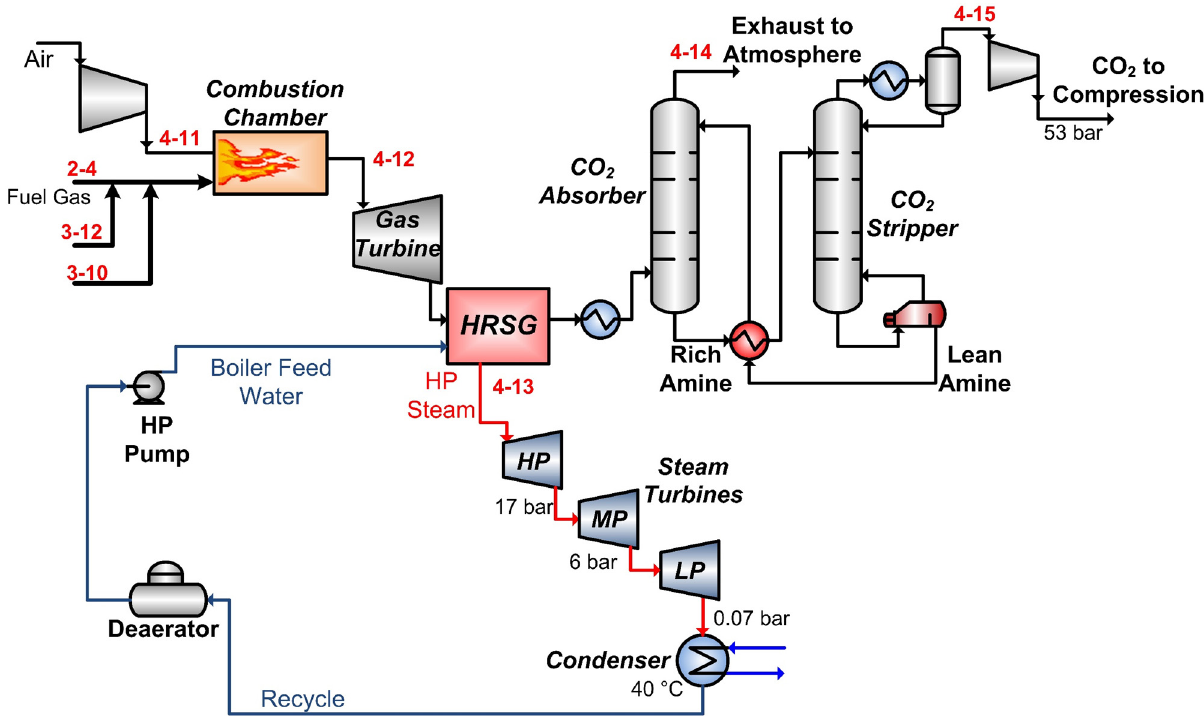
Figure 5. Section 4 option 1: Power generation with post-combustion